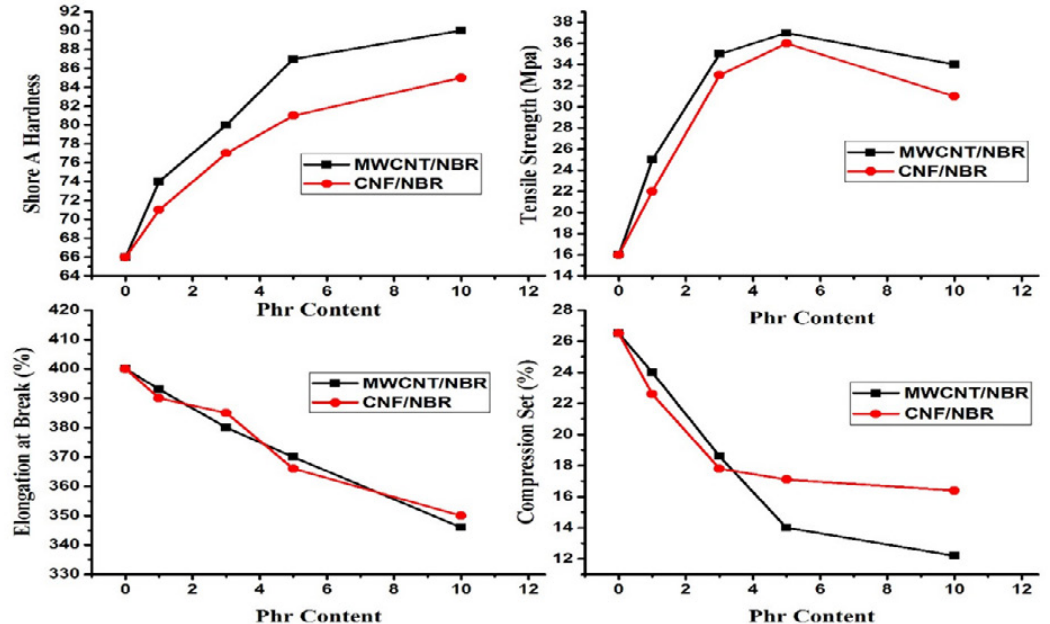
Fig. 6: Mechanical properties of fabricated nanocomposites versus Phr